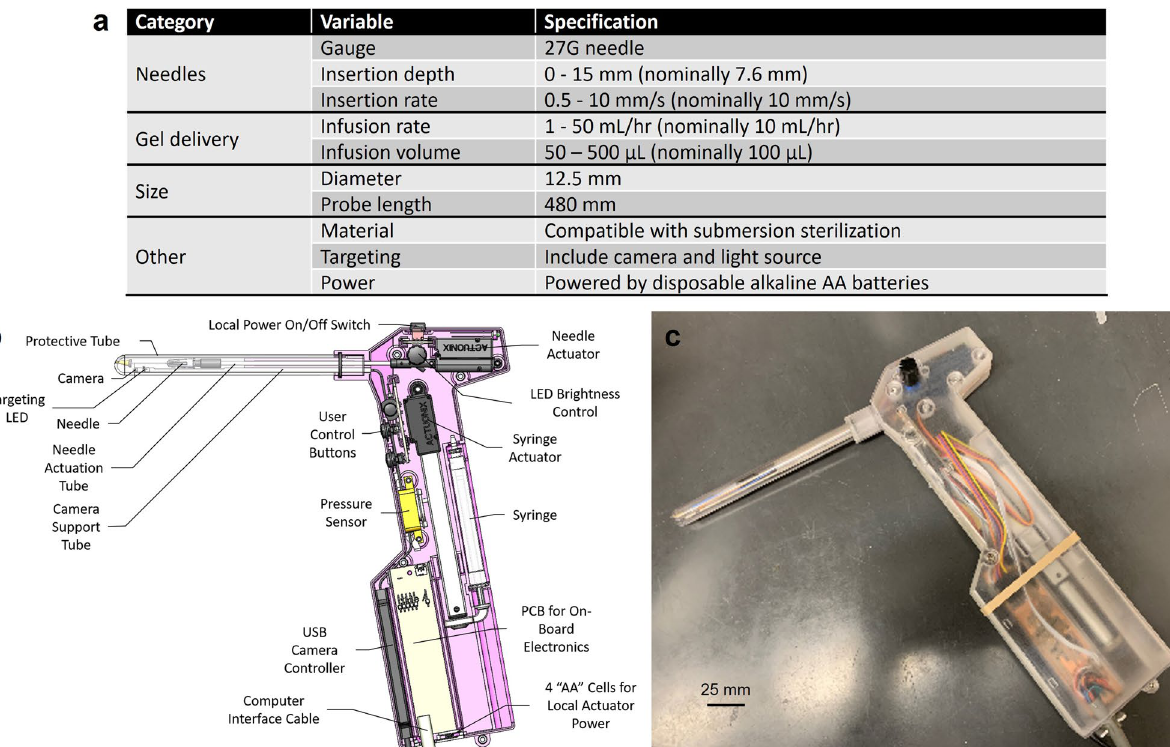
Figure 8. Handheld injector design. ( a ) Injector specifications to deliver EC-ethanol into the swine cervix. ( b ) Initial schematic and ( c ) prototype of automated hand-held needle injector design. Scale bar is 25